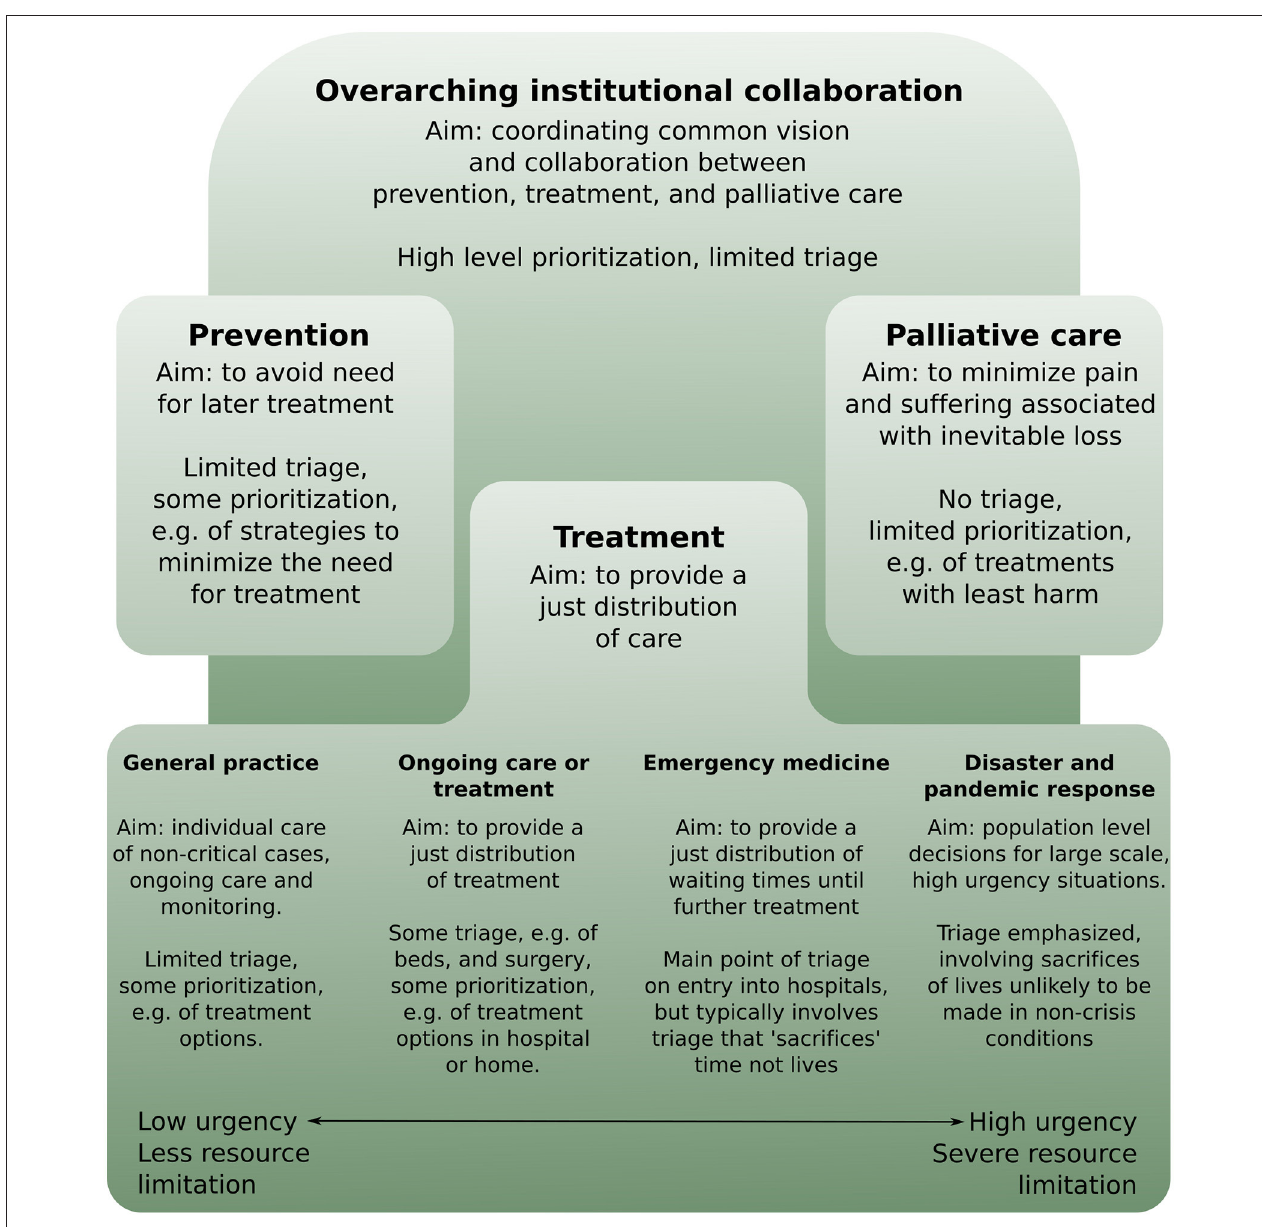
FIGURE 2 | Triage decisions (here defined as prioritization that may involve sacrifice of some critical but resource intensive cases so these resources can be allocated to “the greater good”) can be understood as just one element in a wider system of care. Here we illustrate how triage decisions in medicine are typically concentrated in disaster and pandemic responses, and, albeit with different aims, in emergency medicine, but play a much less emphasized role in other sectors of the wider system of